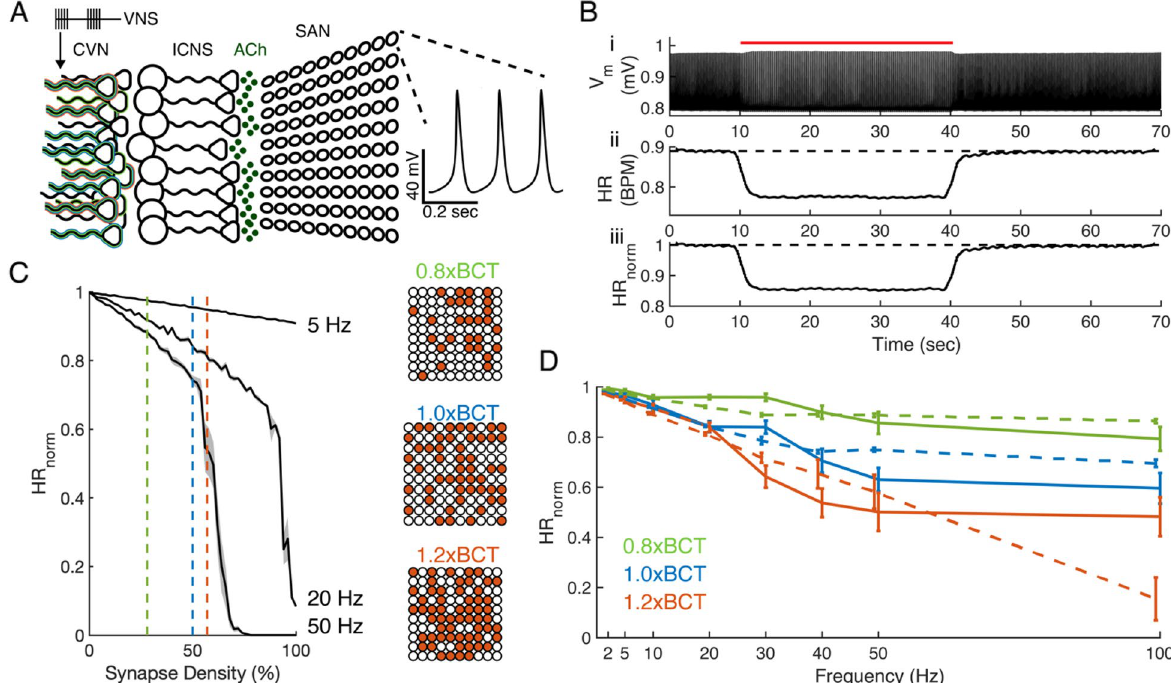
Fig. 7 Implementation and validation of a model of VNS effects on HR. A Schema of computational model. VNS pattern served as input from the cervical vagus nerve (CVN) to post-ganglionic cells in the intrinsic cardiac nervous system (ICNS). ICNS included mechanisms for frequency-dependent VN-to-ICNS synaptic failure and ICNS intrinsic firing. ACh release from ICNS cells to sinoatrial node (SAN) cells was modeled using a three-compartment model; post-synaptic mechanisms for ACh-dependent modulation of ion channels and internal calcium storage